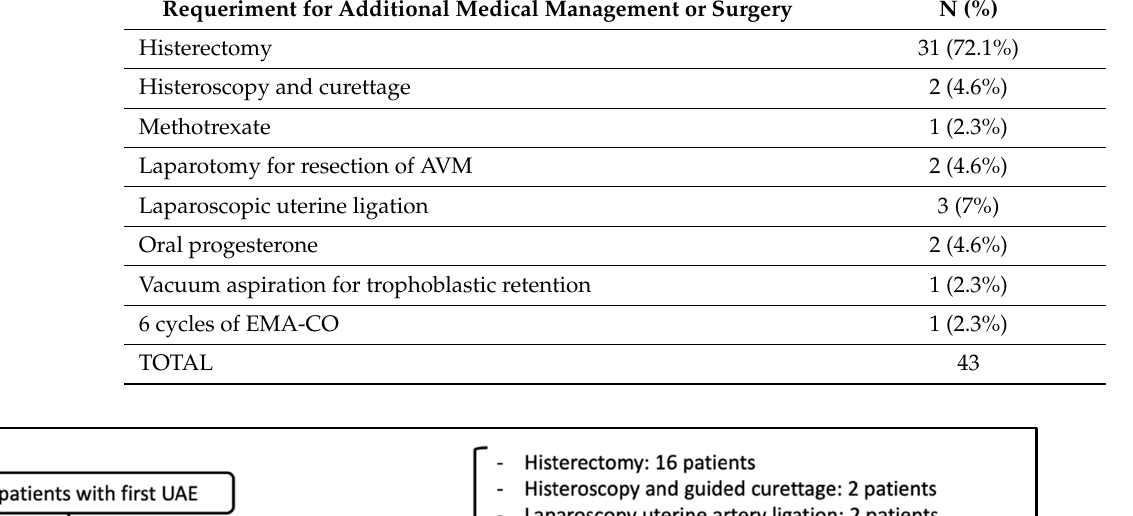
Table 4. Additional medical management or surgery required in the studies included.